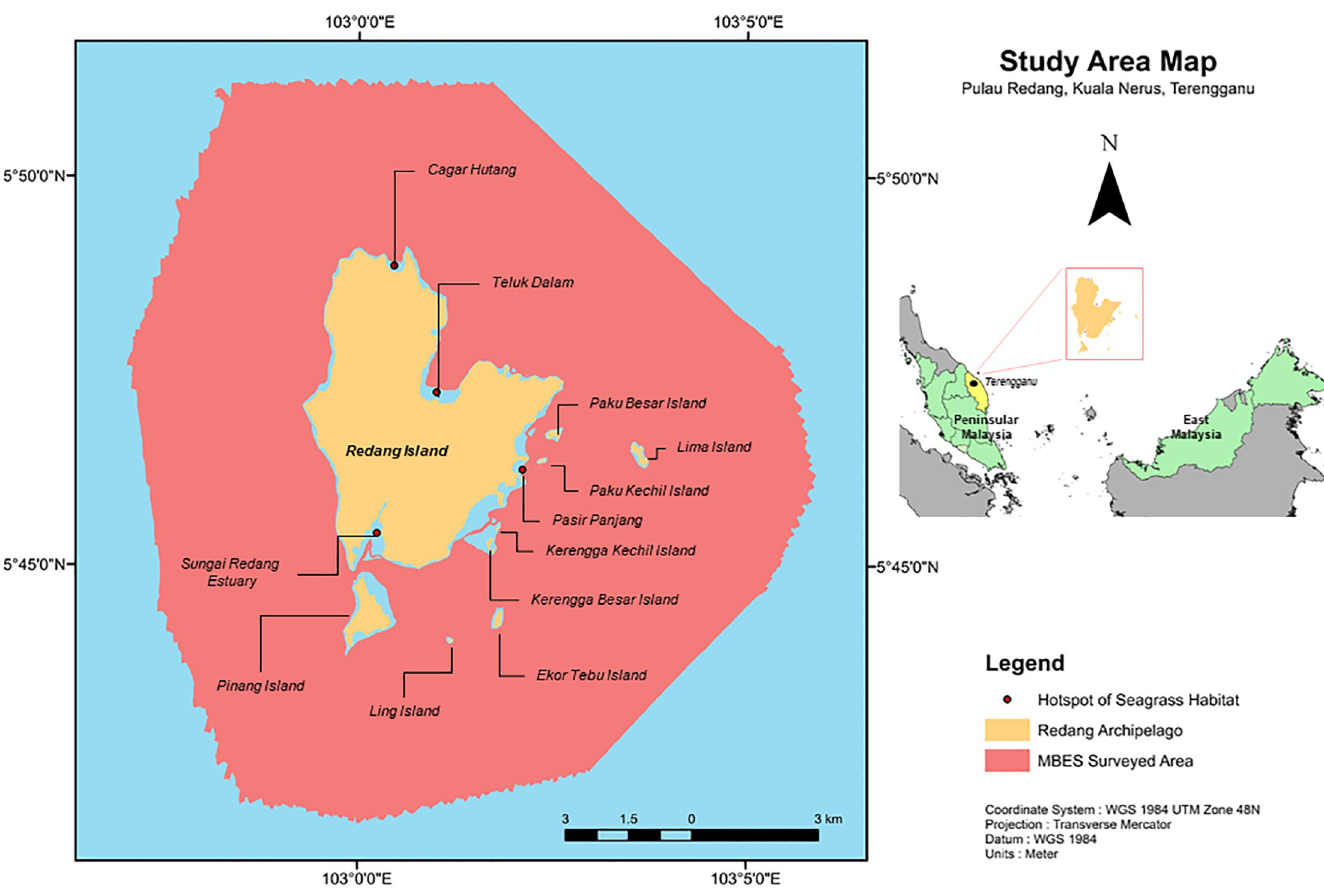
Fig 1. Location of the study area. Study areas are marked with a red dashed polygon which extends two nautical miles from the shoreline of Pulau Redang and other small islands.